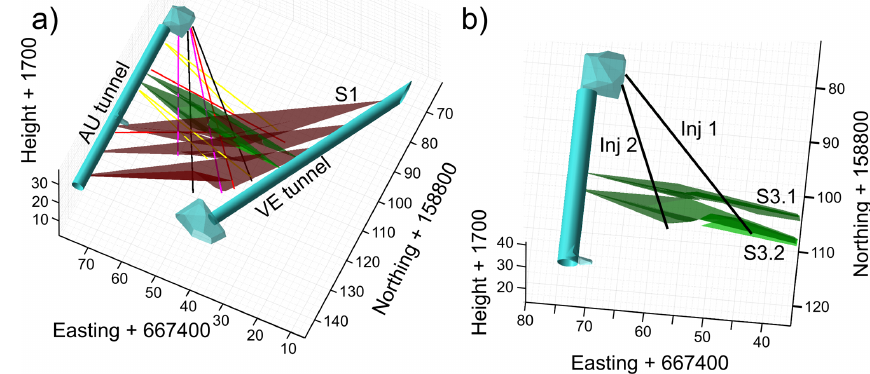
Figure 1. (a) General overview of the ISC experimental site showing the AU (Auflockerungszone, i.e., excavation effects) tunnel, the VE (ventilation test) tunnel, all boreholes, and the two types of shear zones (Krietsch et al., 2018). (b) The volume that is investigated in this study, i.e., the zone between the two brittle–ductile (S3) faults.